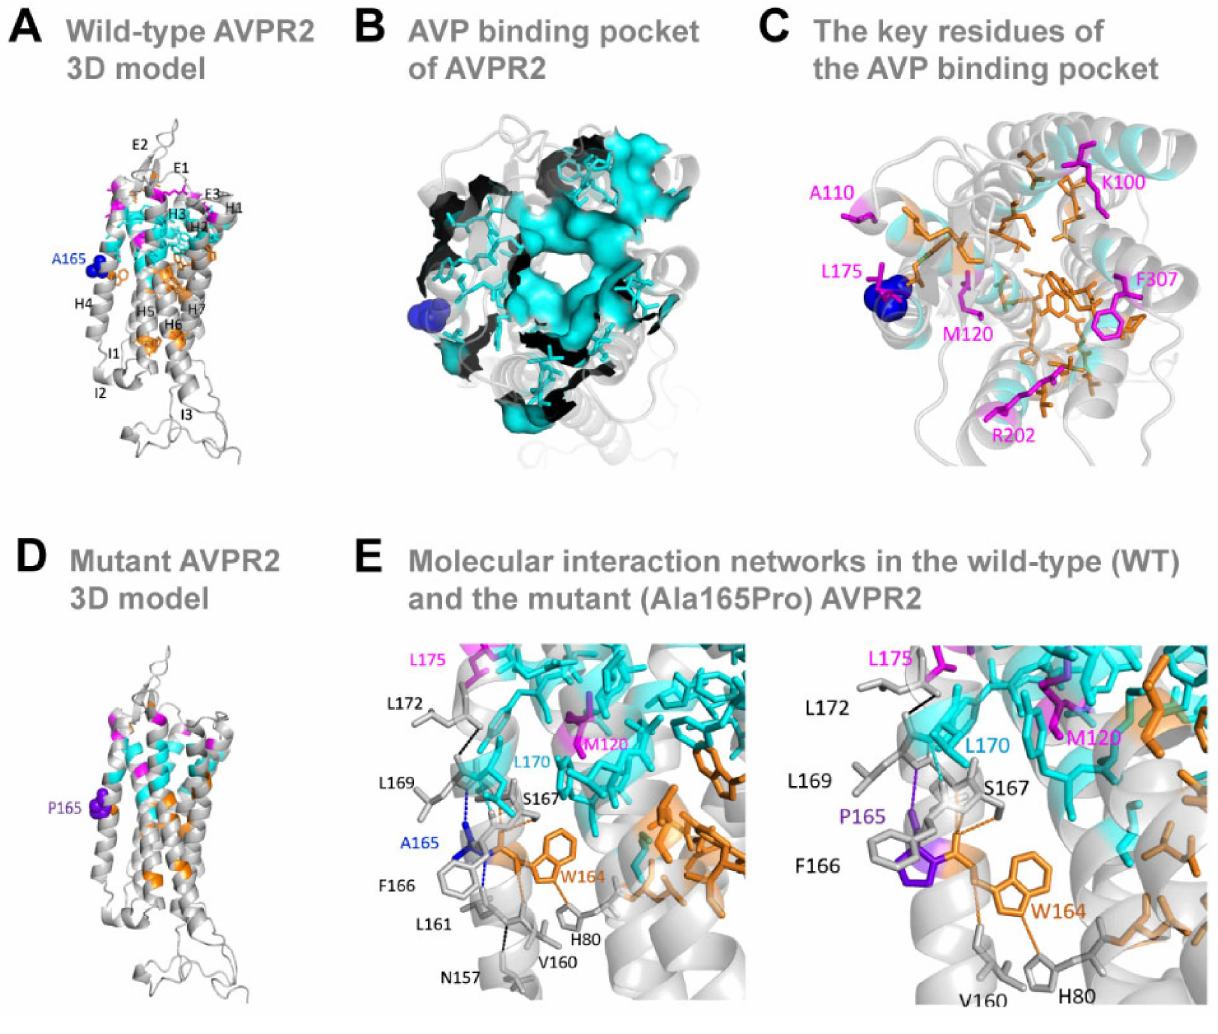
Figure 2. Model structure with key regions of human AVPR2 and Ala165Pro-AVPR2. ( A ) Lateral view of the 3D protein model of the wild-type human AVPR2, including seven transmembrane domains/helices (H1–7) connected with three intracellular (I1–3) and extracellular (E1–3) loops. Dark blue sphere: Alanine residue at position 165 (A165). ( B ) Surface mapping of the vasopressin (AVP) ligand-binding pocket in AVPR2. ( C ) Key residues in the AVP binding region and conserved residues of rhodopsin-like GPCR family. ( D ) Lateral view of the 3D protein model of the mutant Ala165Pro- AVPR2. ( E ) Molecular interaction networks around residue 165 in the WT-AVPR (left panel) and the mutant Ala165Pro-AVPR2 (right panel). Dark blue sphere: Alanine (A) residue at position 165 (A165); Purple blue sphere: Proline (P) residue at position 165 (P165); Cyan sticks and surface: AVP binding pocket; Orange sticks: conserved residues; Magenta sticks: -binding residues; Grey sticks: other residues in the network; Black dash: hydrogen bonds. Residues are indicated by their position number, preceded by the corresponding amino-acid letter: A, Alanine; F, Phenylalanine; H, Histidine; L, Leucine; M, Methionine; N, Asparagine; P, Proline; S, Serine; V, Valine; W,